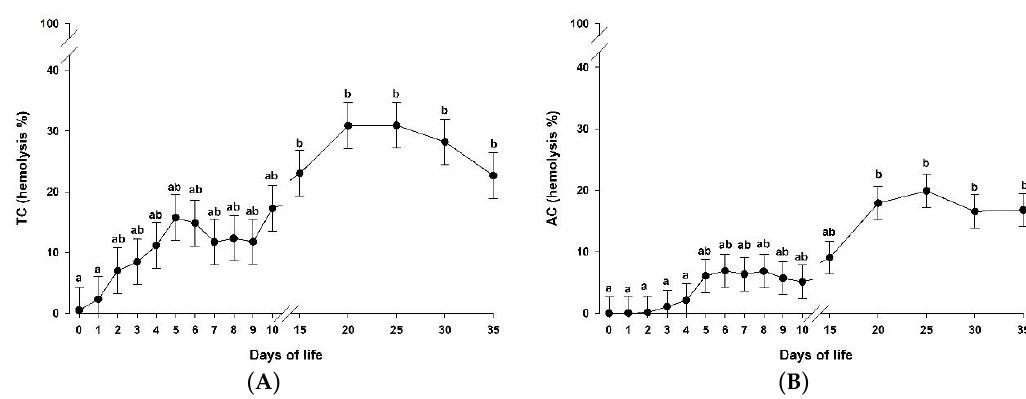
Figure 3. Serum total complement system (TC) activity ( A ) and alternative pathway (AC) activity ( B ) in the three groups together (MR-NS, MR-DHA-9 and MR-DHA-18; n = 30) from day 0 to day 35 of life. Different lowercase letters (a-b) indicate significant ( p < 0.05) differences between time points. Results are presented as least squares means ± standard error of the mean. p -values are shown in Table 3. MR-NS: milk replacer without supplementation of a microalgae-derived product rich in DHA; MR-DHA-9: milk replacer with supplementation of 9 g of a microalgae-derived product rich in DHA; MR-DHA-18: milk replacer with supplementation of 18 g of a microalgae-derived product rich in